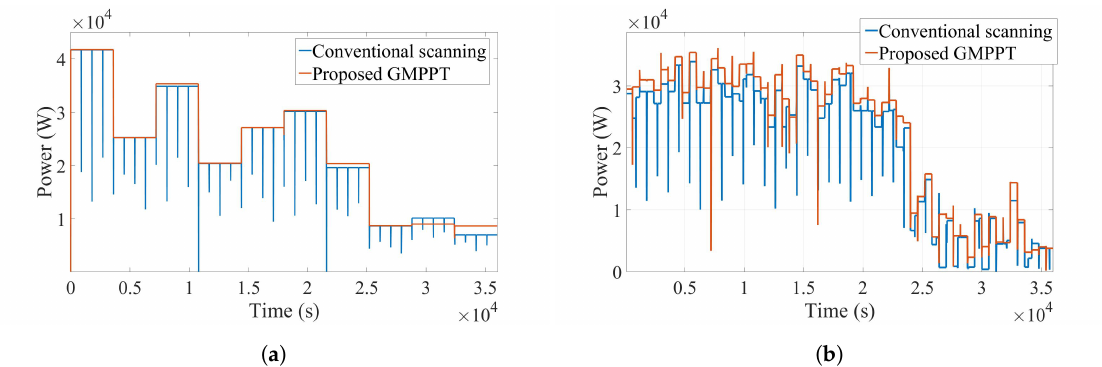
Figure 12. Tracking power for long-term testing at tested weather conditions. ( a ) Steady change; ( b ) rapid change.